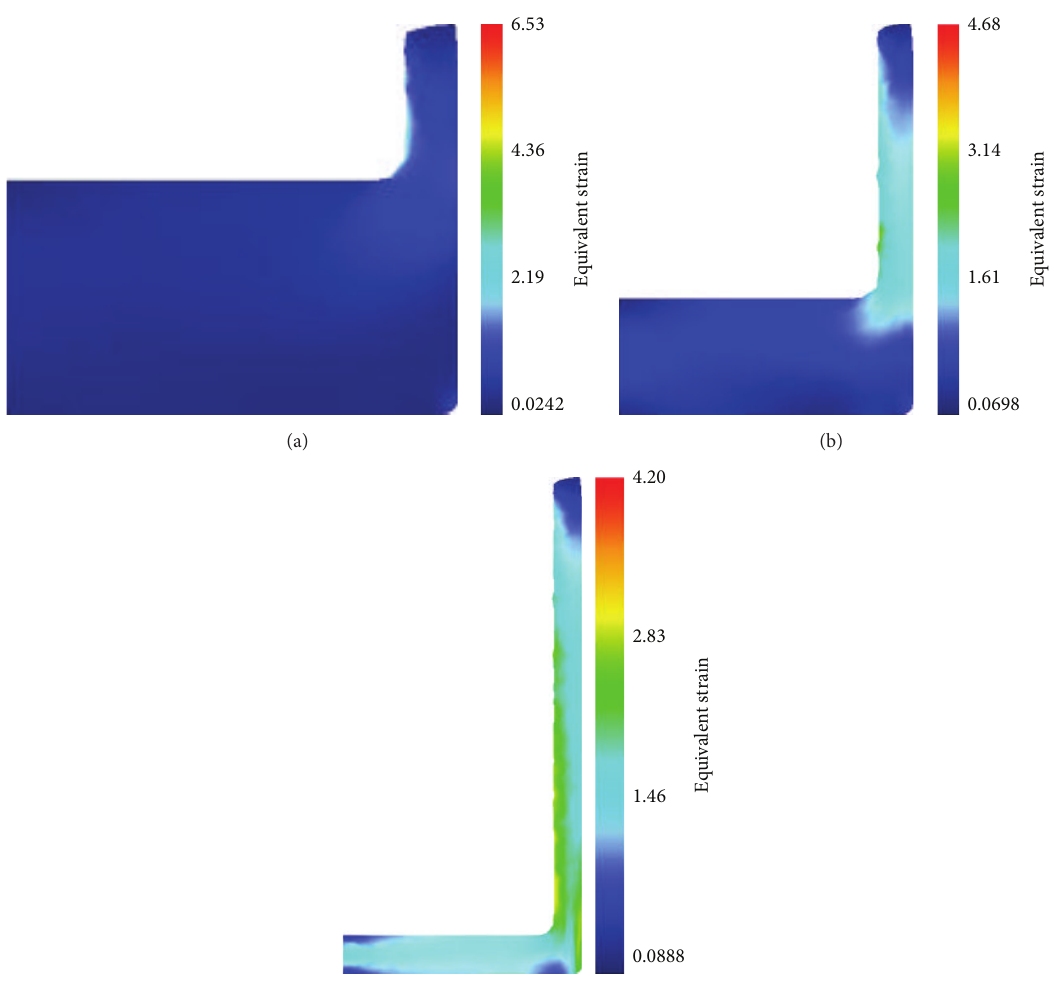
Figure 5: Equivalent strain contours with different deformation: (a) Δ h = 5mm; (b) Δ h = 10mm; (c) Δ h = 20 mm.